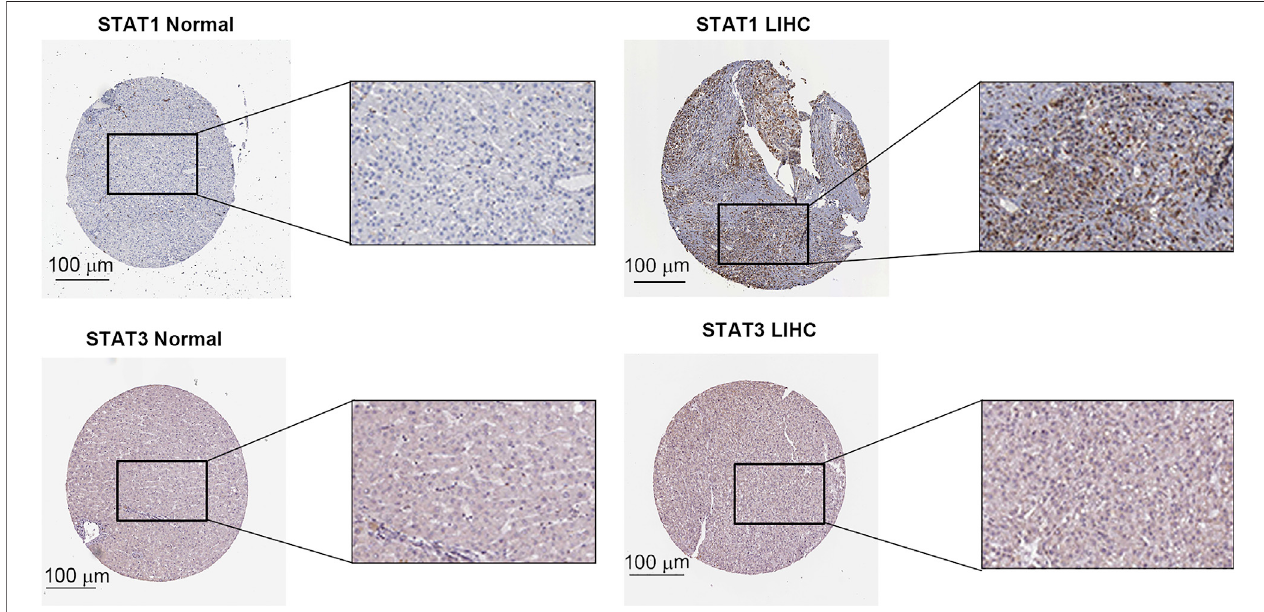
FIGURE 2 | Validation of STAT1 and STAT3 protein levels in The Human Protein Atlas database (HPA).